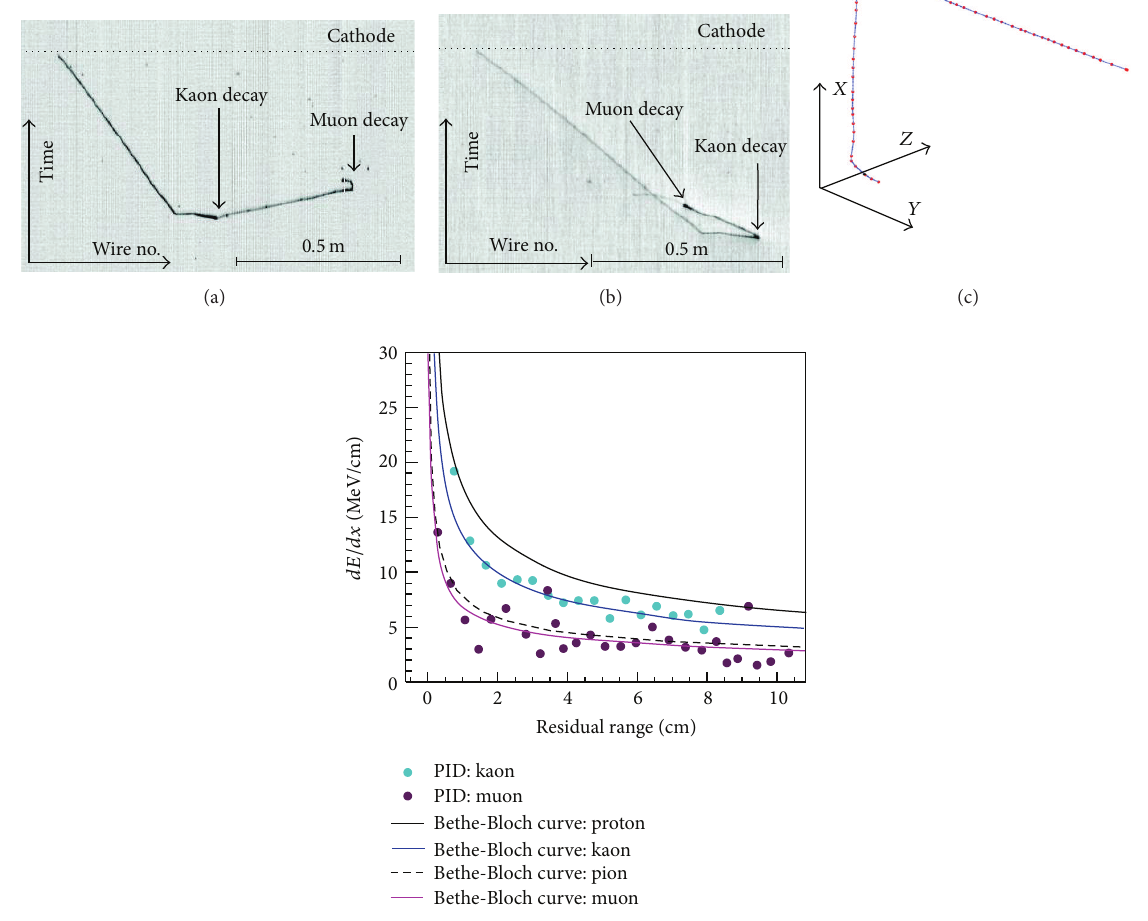
Figure 14: Example of a decaying kaon candidate observed in the CNGS data ( 𝐾 : 90 cm, 325 MeV; 𝜇 : 54 cm, 147 MeV; 𝑒 : 13 cm, 27 MeV): (a) the Collection view; (b) the Induction2 view; (c) the 3D reconstruction (fit nodes are marked with the red dots); (d) 𝑑𝐸/𝑑𝑥 sequence for the kaon track (cyan dots) and the muon track (violet dots) superimposed on the theoretical Bethe-Bloch curves. The muon data points with the high 𝑑𝐸/𝑑𝑥 are due to the additional energy of delta rays. They are attached to the muon track (visible black dots on the muon track in the Collection view). Their energy contribution is in agreement with the energy loss distribution expected for a muon